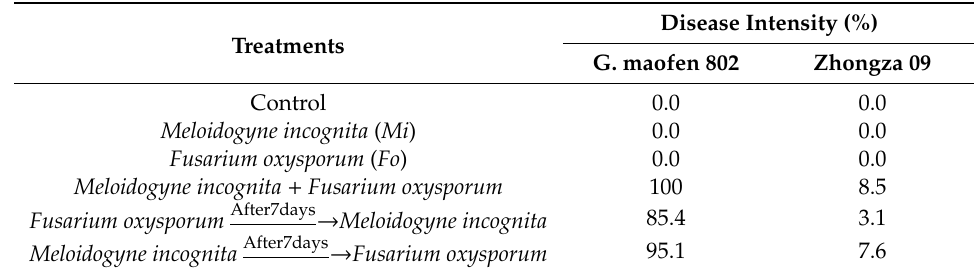
Table 1. Disease intensity on two tomato cultivars (G. maofen 802 and Zhongza 09) under greenhouse conditions at 14 days after inoculation